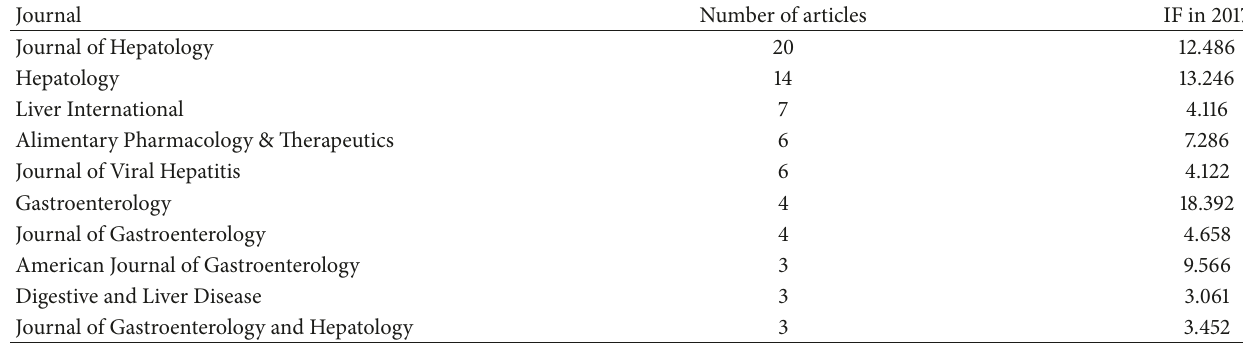
Table 1: Journals with more than three articles in the 100 most-cited